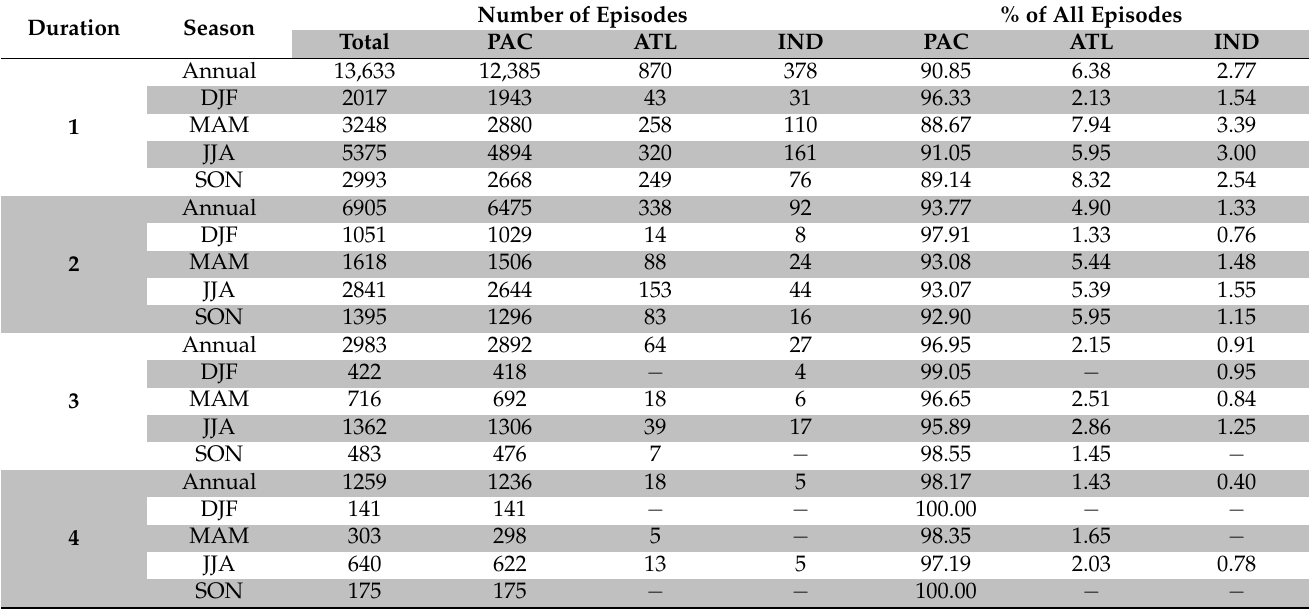
Table 2. Number of episodes and percentages of detected blockings with durations spanning from 1 to 12 days within three different regions: PAC, ATL, and IND (see text for further details). The figures are discriminated by season and correspond to the entire analyzed 74-year period. Seasons with no registered events were